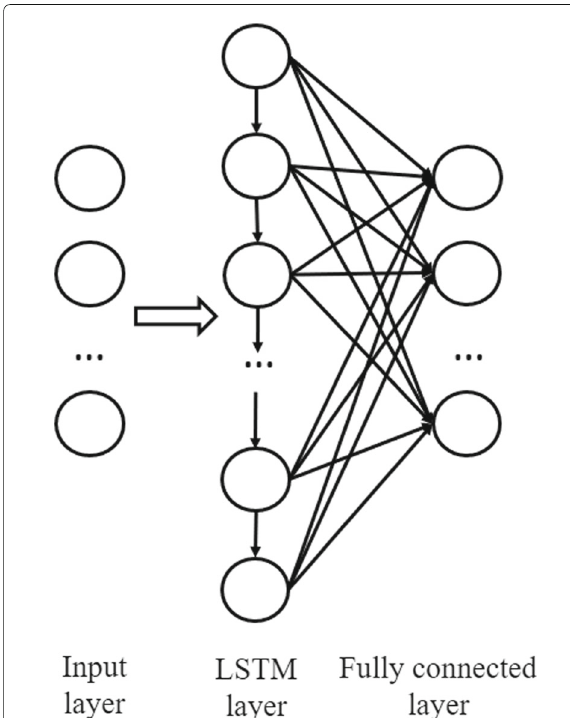
Fig. 6 Model structure diagram. At the LSTM layer, each circle represents an LSTM unit, and the down arrows in this layer represent